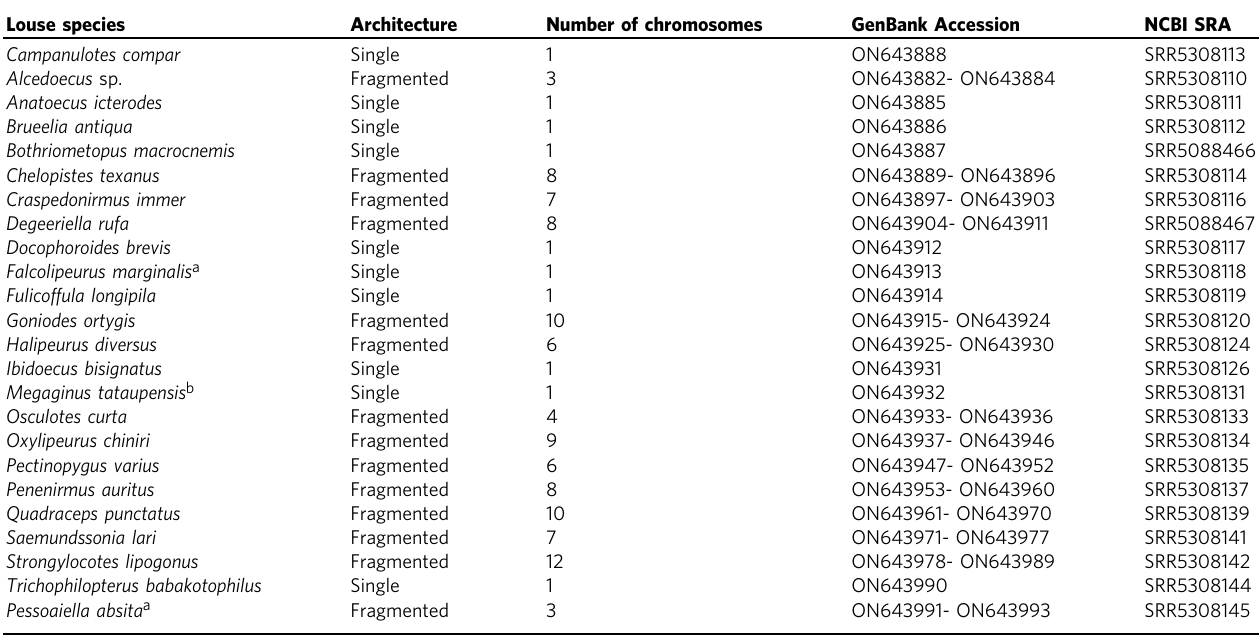
Table 1 Summary of newly assembled mitogenomes from parasitic lice, including accession numbers for the original raw data used for